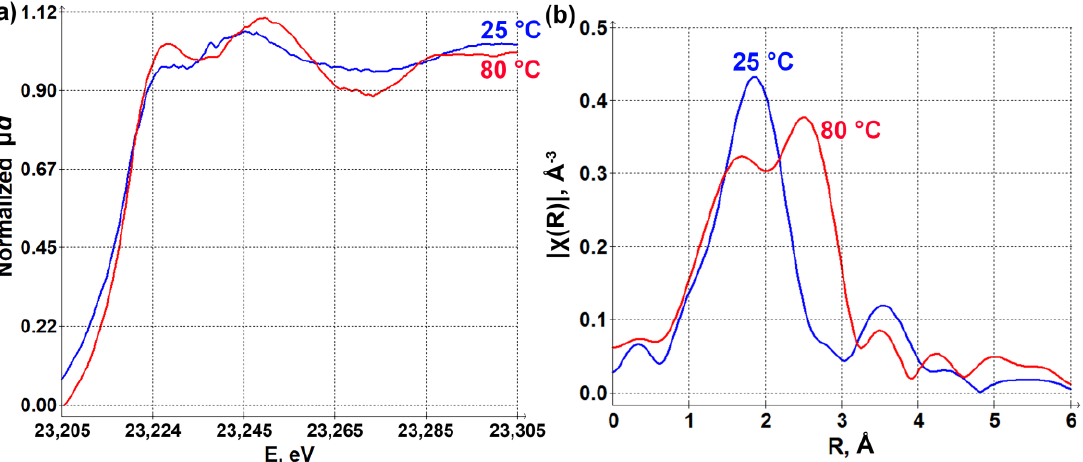
Figure 6. ( a ) Rh K ‐ edge XANES spectra and ( b ) corresponding EXAFS data for Rh ‐ catalyst at 25 ° С and 80 ° С .